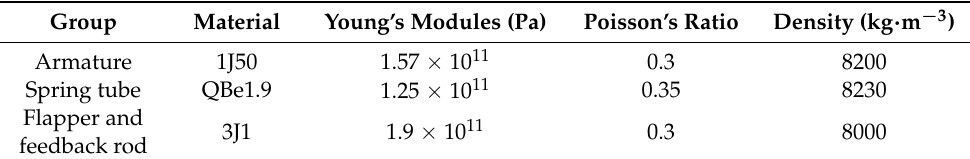
Table 1. Material properties of the flapper-armature assembly.